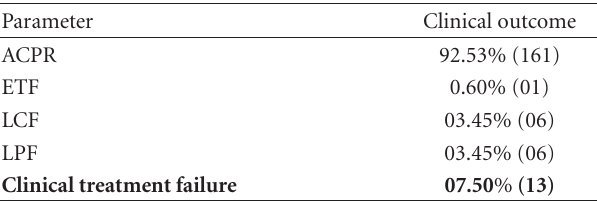
Table 2: Clinical outcome of patients attending CAMEF during the in vivo study, 2007-2008 after treatment with Malartin and